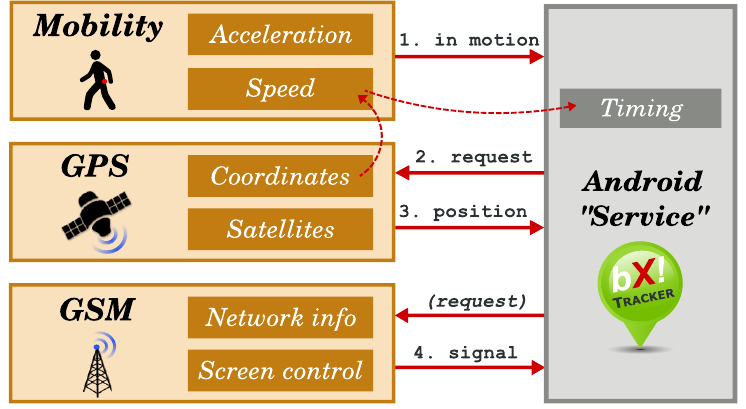
Figure 6. Implementation of the BX Tracker